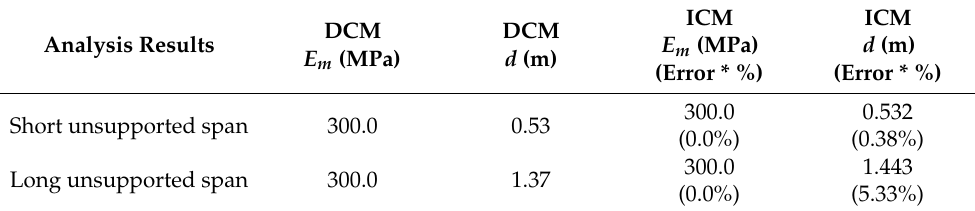
Table 2. Output data obtained by ICM compared with the input data of DCM.